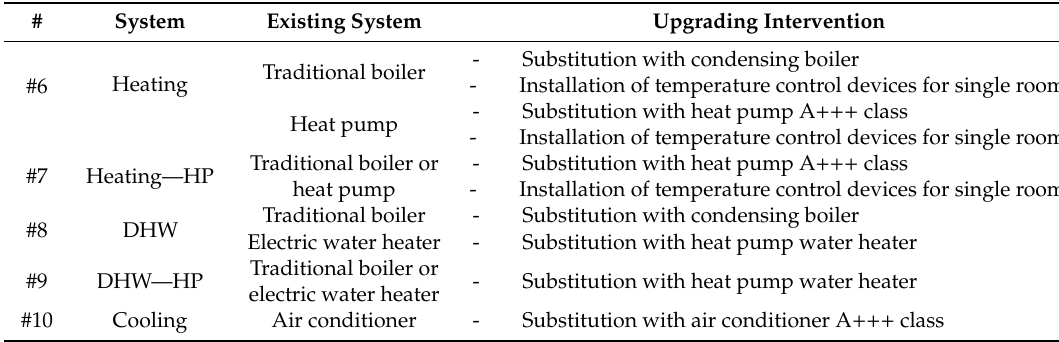
Table 2. Interventions of technological systems upgrading.